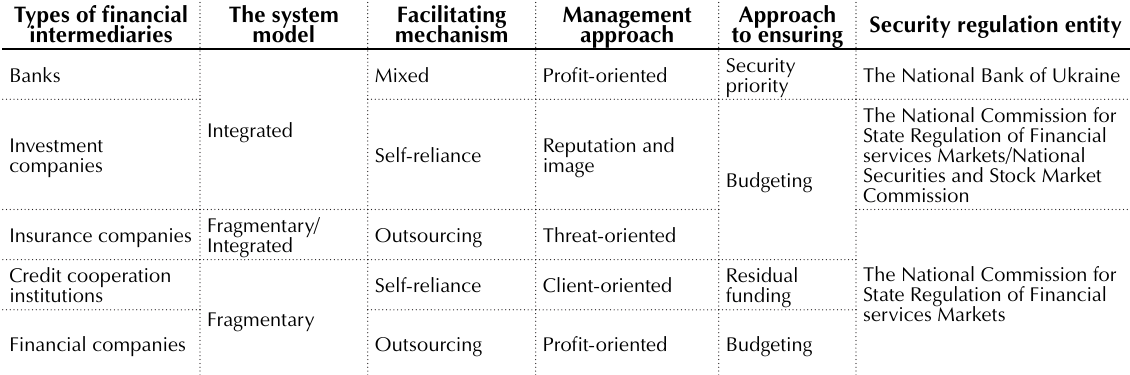
Source: Compiled by the